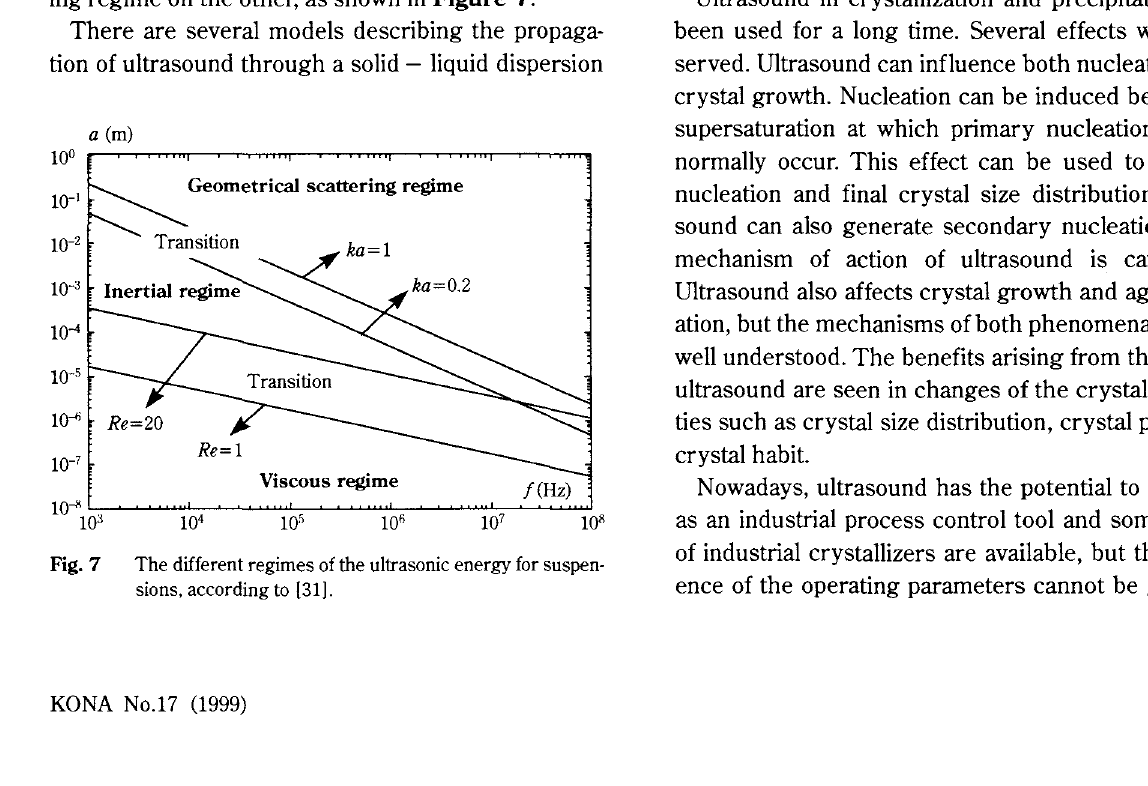
Geometrical scattering regime